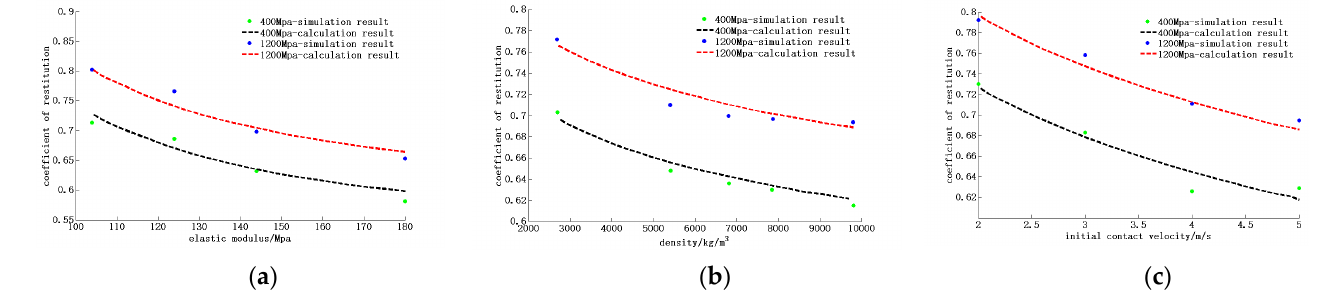
Figure 7. Influence of the different parameters on the coefficient of restitution: ( a ) influence of the elastic modulus, ( b ) influence of the density, ( c ) influence of the velocity.